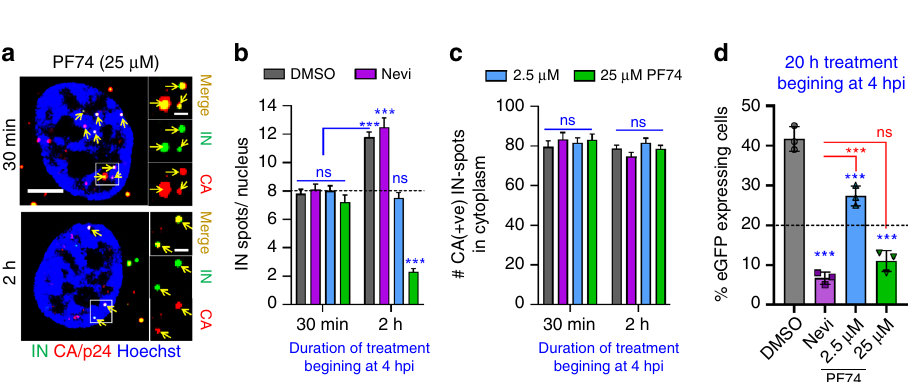
Fig. 6 NS localization stabilizes VRCs in the nucleus. TZM-bl cells were infected with VSV-G pseudotyped HIVeGFP labeled with INmNG for 4 h (half- time of nuclear import), at which time DMSO, Nevi (10 μ M), or the indicated concentrations of PF74 was added and cells were fi xed after 30 min or after 2 h of PF74 application to quantify nuclear IN puncta ( a , b ) and cytosolic CA-positive IN puncta ( c ) or incubated for additional 20 h to measure infection ( d ). a , b A high dose of PF74 results in the displacement of IN puncta from NSs and disappearance of IN puncta. a Single Z-stack images showing the presence of CA/p24 immuno-labeled (red) IN puncta (green) in the nucleus (blue) of 25 µ M PF74 treated cells after 30 min (top panel) or 2 h (bottom panel). Analysis from 30 to 40 cells in each of the three independent experiments showing the average number of IN puncta per nucleus ( b ) or CA-positive IN puncta in the cytoplasm ( c ) is shown. d The fraction of eGFP-expressing TZM-bl cells treated with indicated drugs at 4 hpi was determined at 24 h. Dashed lines represent baseline nuclear import upon drug addition ( b ) and 50% of DMSO infection ( d ), respectively. Scale bar in ( a ) is 5 μ m and inset in ( a ) is 1 μ m. Error bars in panels ( b – d ) are mean values ± SEM. Data in ( b , c ) are from >80 nuclei/cells containing >1500 IN complexes and three independent experiments ( a – d ). The statistical signi fi cance in ( b – d ) was determined by two-tailed Student ’ s t test (ns, p > 0.05; *** p < 0.001). Results of statistical analyses in ( d ) vs. DMSO control is shown in blue vs. Nevi that is shown in red. Statistical analysis in ( b ) with respect to a 30 min treatment with DMSO is shown in blue. Source data are provided as a Source Data fi WT vs. mutant F284A CPSF6, which is defective for CA binding,